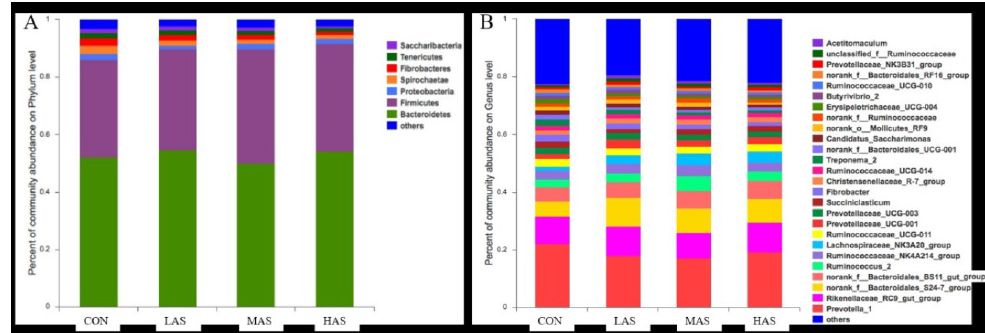
Figure 4. Comparison of the relative abundance of bacterial communities in the phylum ( A ) and genus ( B ) level.